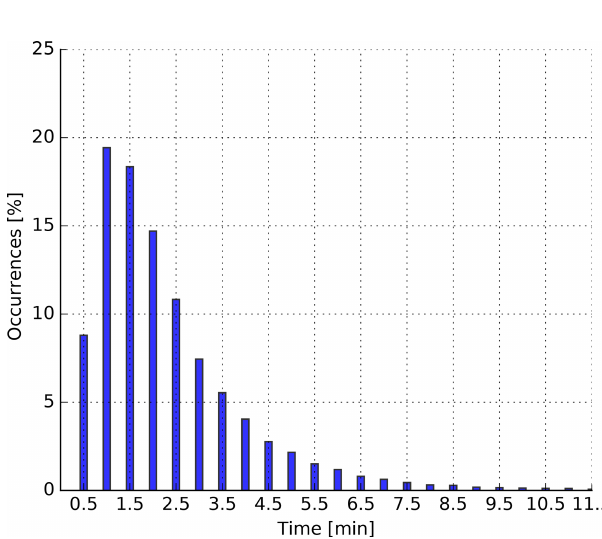
Figure 13. Histogram of the time period of recirculation events. Recirculation events are defined by threshold in terms of q c of 0.01gkg − 1